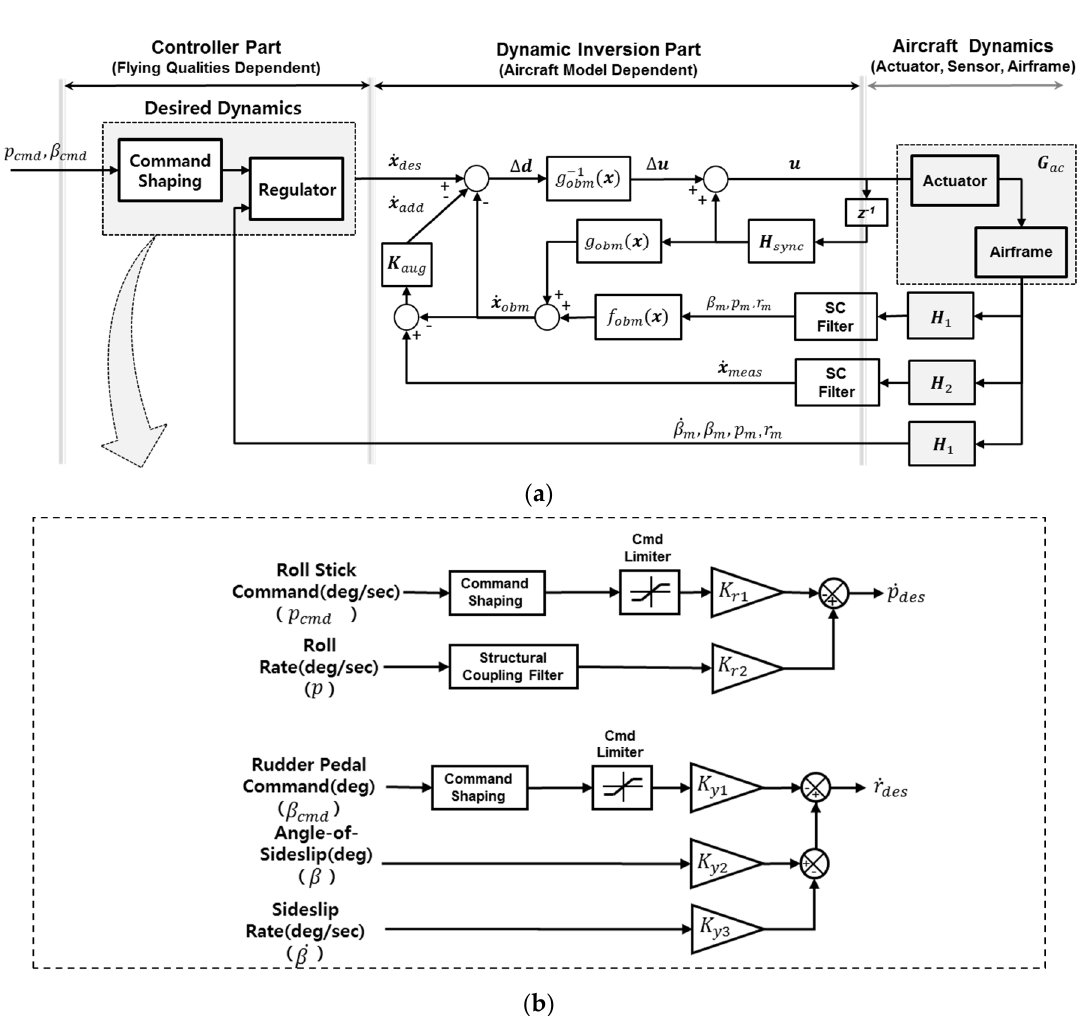
Figure 3. Detailed structure of the Hybrid INDI control in lateral-directional axis ( a ) dynamic inversion part ( b ) desired dynamics part.